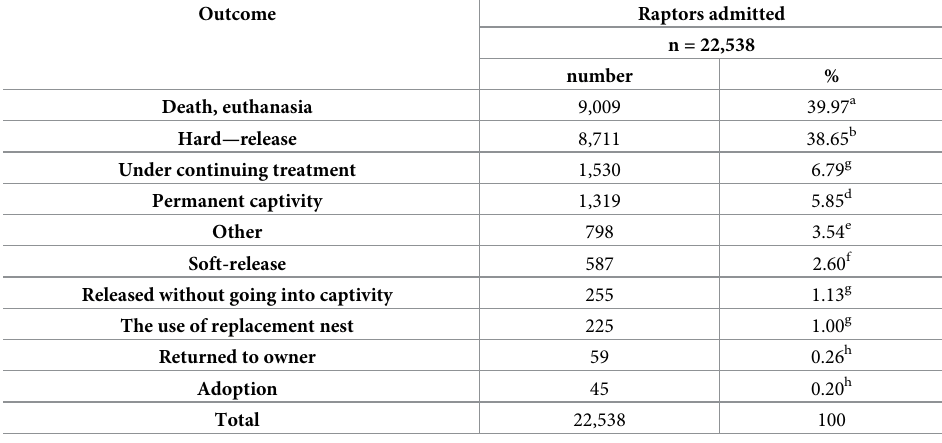
Returned to owner